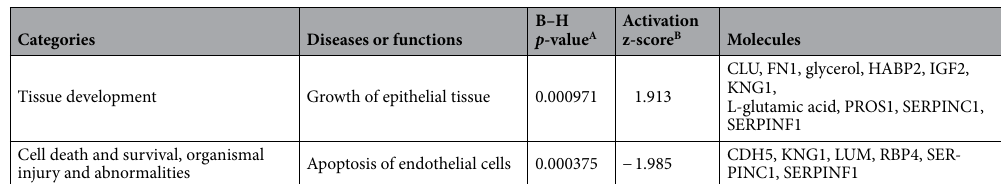
Table 4. Disease or function analysis using IPA. Integrated analysis of metabolites and proteins with VIP scores > 1.0 between 1st high flux and MCO dialyzer. A Benjamini–Hochberg (B–H) p -value is the adjusted p -value using the B–H procedure. B Activation z-score was calculated by IPA software and was used to predict whether a specific disease or biological function was increased (positive z-score) or decreased (negative z-score). MCO, medium cut-off; IPA, ingenuity pathway analysis; VIP, variable important in projection;